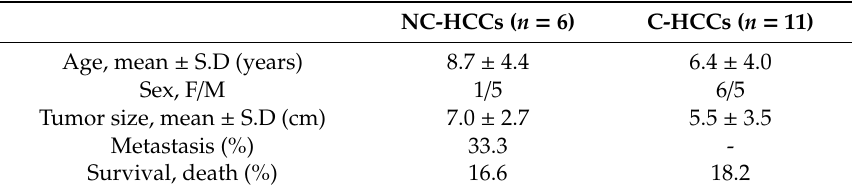
Table 1. Clinico-Pathological Indicators and Survival Conditions of Pediatric HCCs.